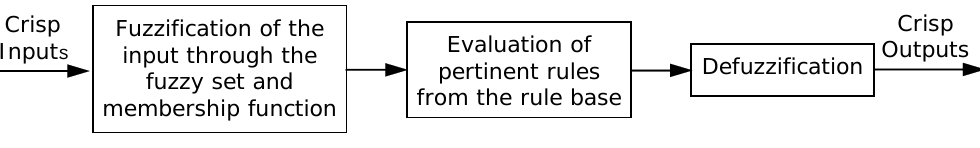
Figure 1. “General depiction of Fuzzy Expert System”. Source: Own contribution If general depiction of fuzzy expert system is adopted in Figure 1, the selecting of optimal shift numbers’ fuzzy model can be presented in Figure